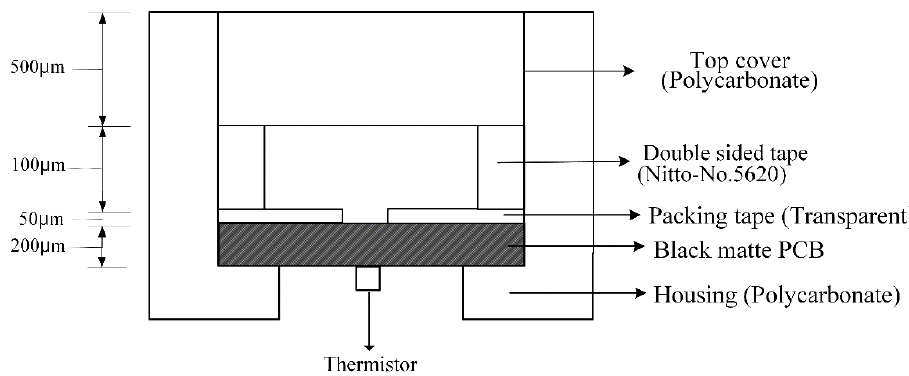
Figure 3. The cross section of the biochip. First, a 0.2 T thick matte black flexible PCB was used at the bottom of the chip.